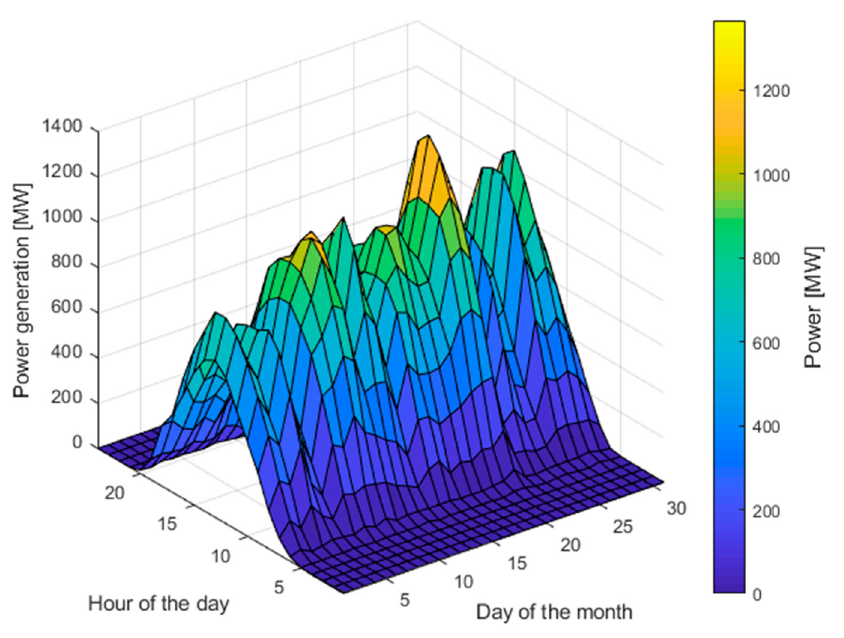
Figure 3. PV generation on a country level during May 2020.